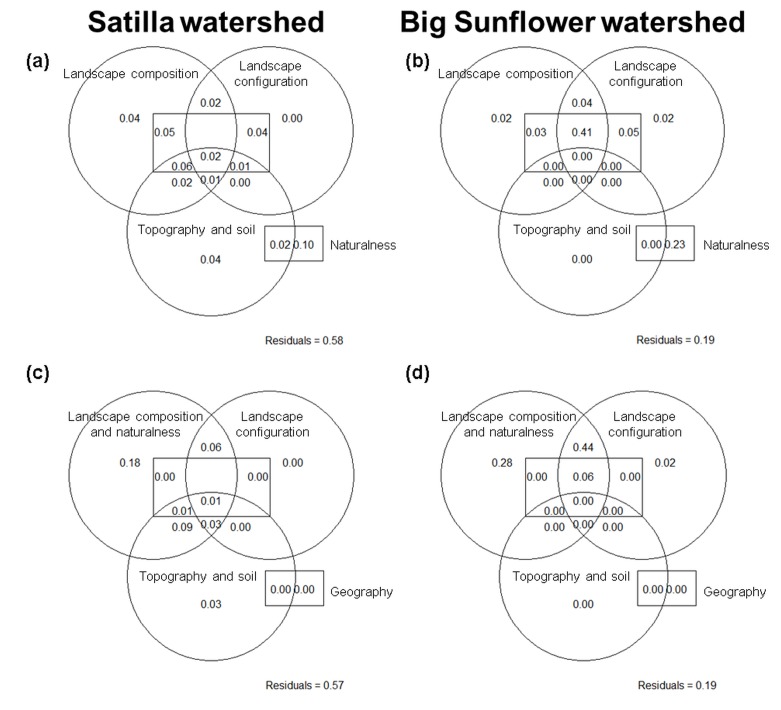
Variation partitioning for ESS supply in the Satilla (a, c) and Big Sunflower (b, d) watersheds without geographic location (a-b) and with geographic location (c-d).p<0.01 and values <0 are not shown; the indicated values display the variance captured by the indicator groups on landscape composition, naturalness, landscape configuration, topography and soil parameters selected from Table 1; the indicators were selected based on permutation p-values; the variance is captured as adjusted R² for single (non-overlapping areas) and combined categories (overlapping areas).